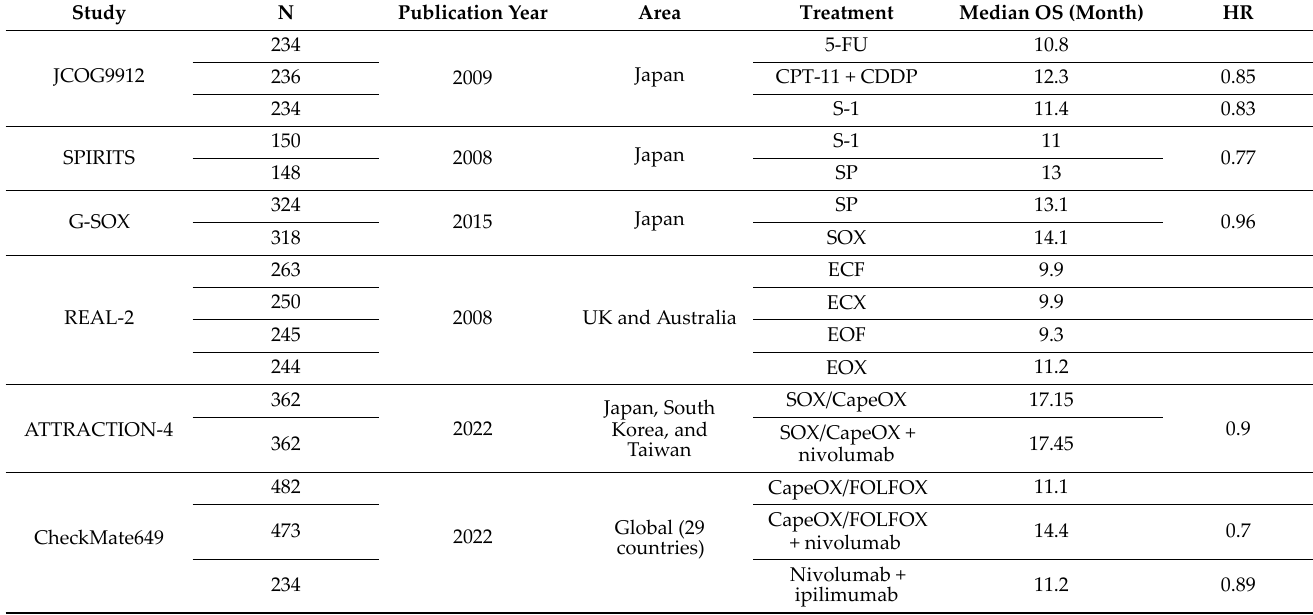
Table 1. Pivotal randomized controlled clinical trial for first‑line human epidermal growth factor receptor 2 (HER2)‑negative gastric